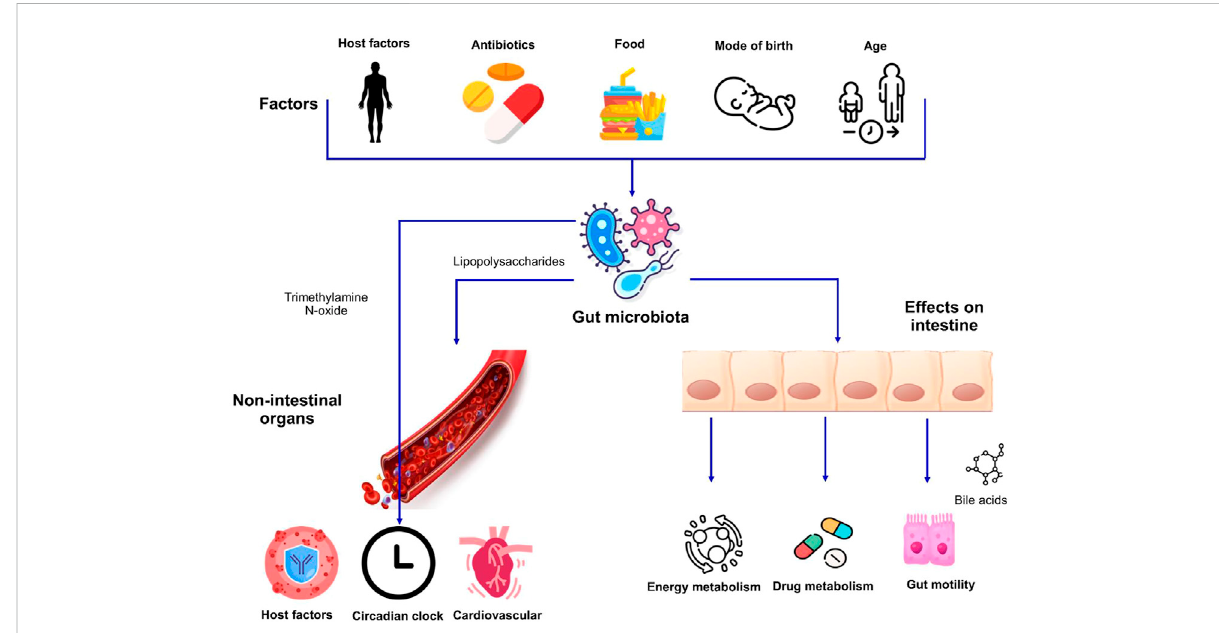
FIGURE 1 Factors affecting the gut microbiota and its impact on host physiology. Host factors i.e., genetics and age as well as exogenous factors can in fl uencethemakeupofmicrobiota.Theinteractionsbetweentheintestinalmicrobiomeanddietaryhabitsresultinalterationsindifferentaspectsof human physiology affecting both the intestinal and non-intestinal